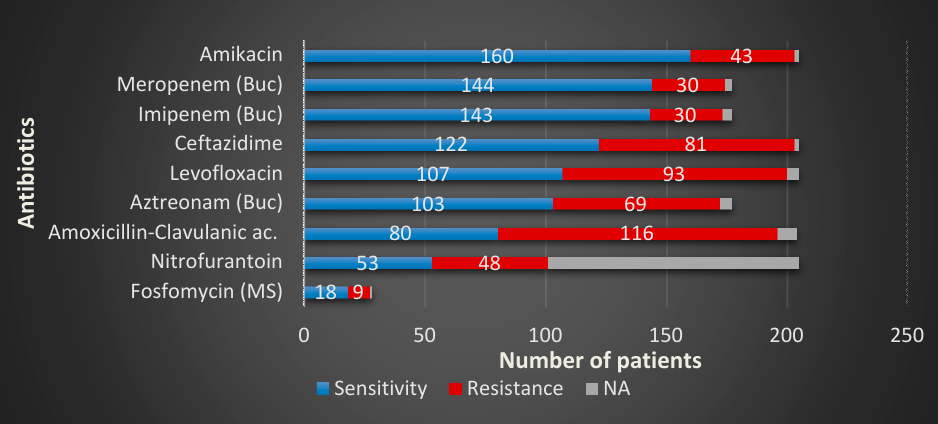
Figure 4. Klebsiella spp. overall sensitivity and resistance profiles in the study group.